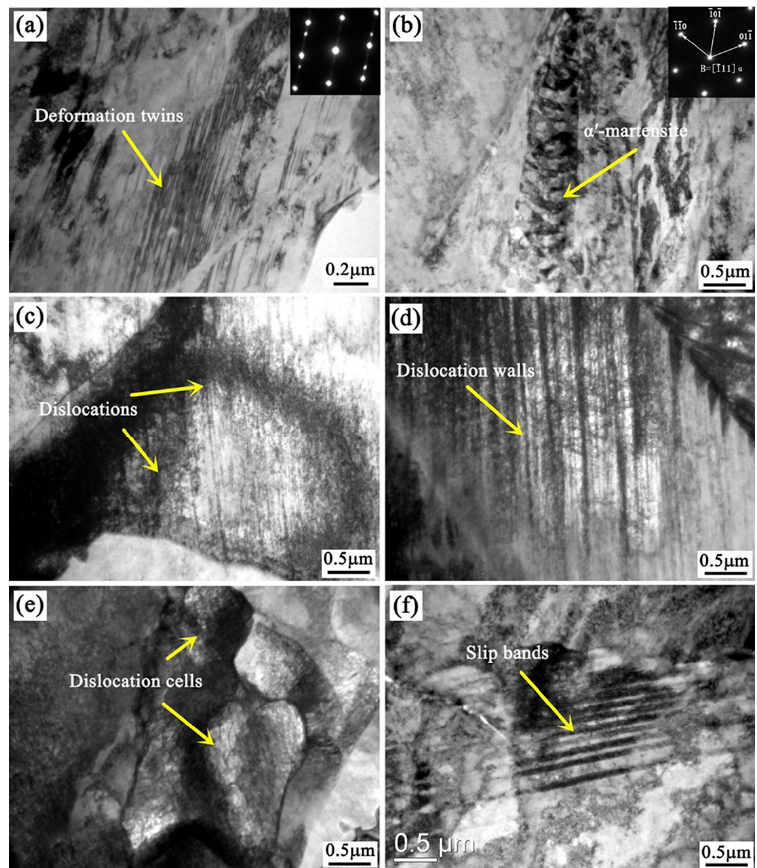
Figure 7. TEM micrographs of the experimental steel after deformation at different temperatures of ( a , b ) 25 °C, ε = 55%; ( c , d ) 300 °C, ε = 36%; and ( e , f ) 600 °C, ε = 64%.